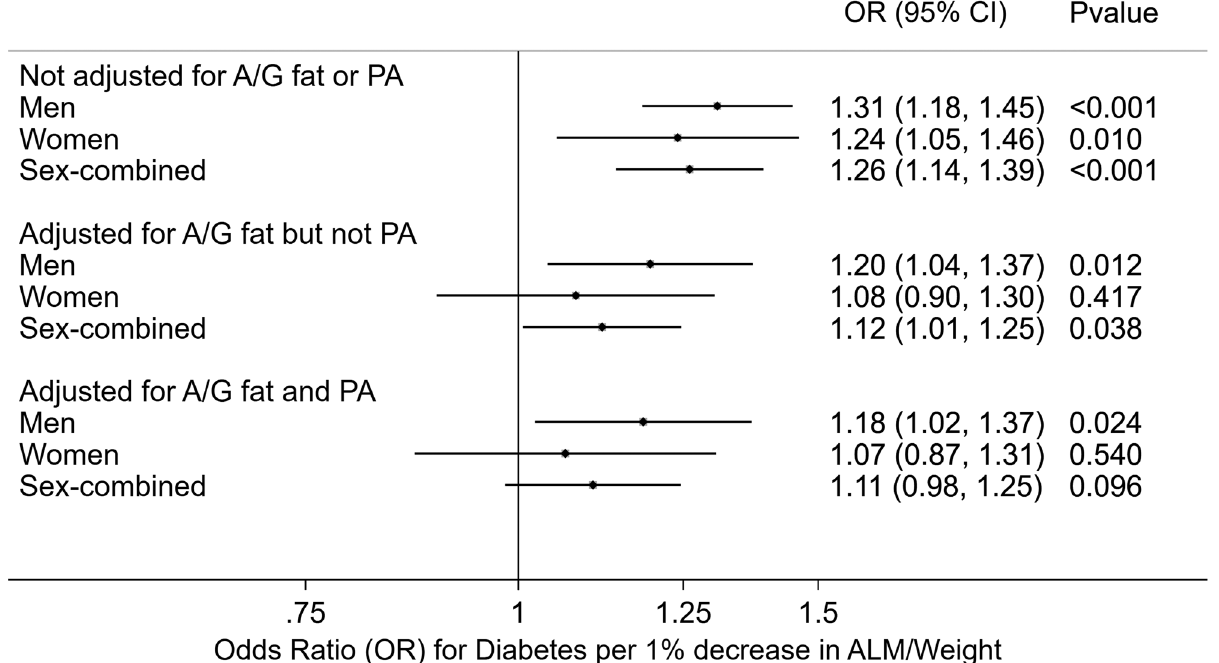
Fig. 1 The odds of diabetes were 1.31 times higher in men and 1.24 times higher in women per percent decrease in appendicular lean mass (ALM)/weight after controlling for age, race, height, smoking, and education. After controlling for android/gynoid (A/G) fat, the odds of diabetes were 1.20 times higher for each percent decrease in ALM/weight in men an inverse association was also observed in women albeit was not statistically signi fi cant. After additionally controlling for physical inactivity (PA), the odds of diabetes were 1.18 times higher for each percent decrease in ALM/weight in men an inverse association was also observed in women albeit was not statistically signi fi cant.